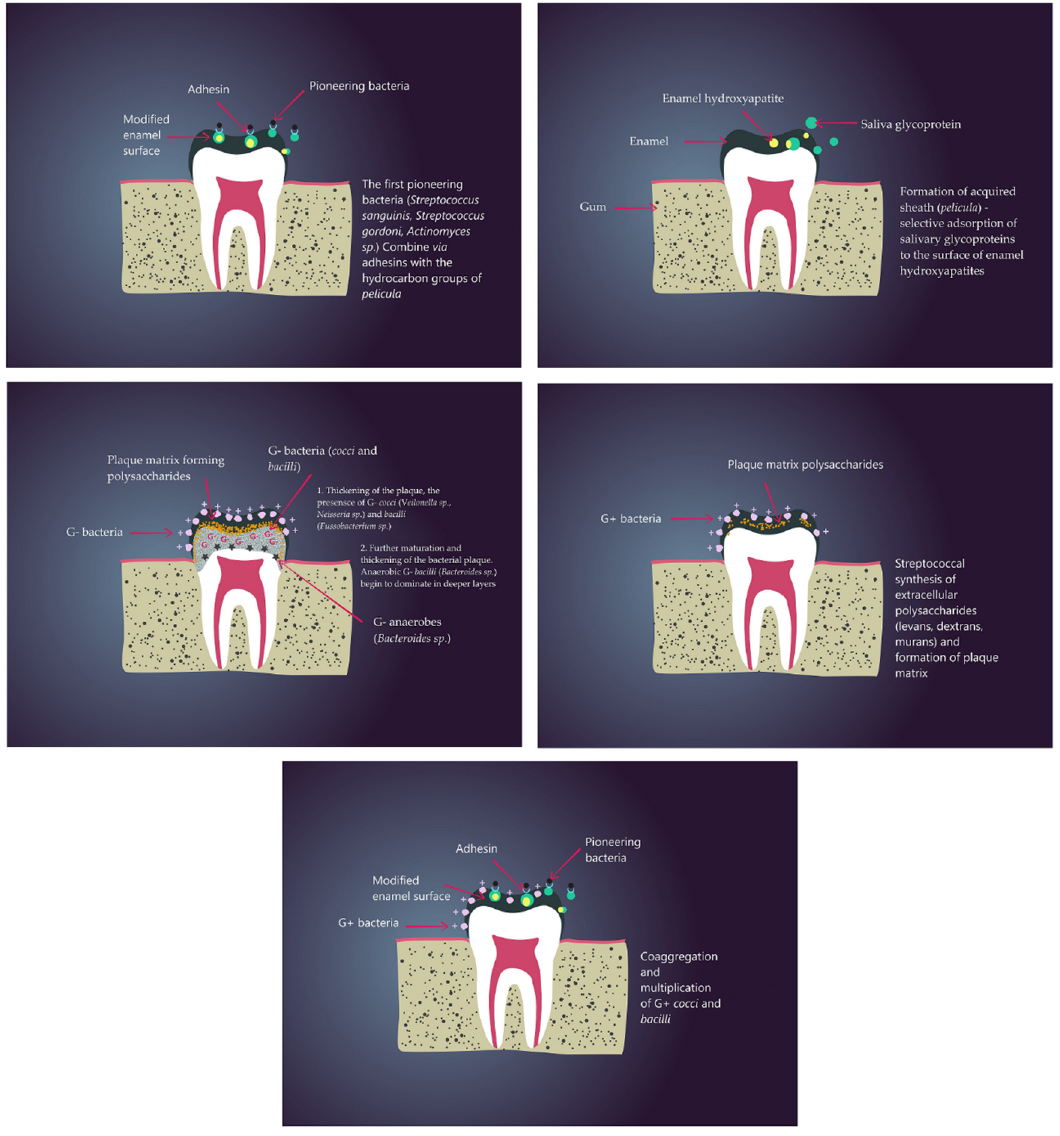
Figure 1. A scheme showing the stages of biofilm formation.